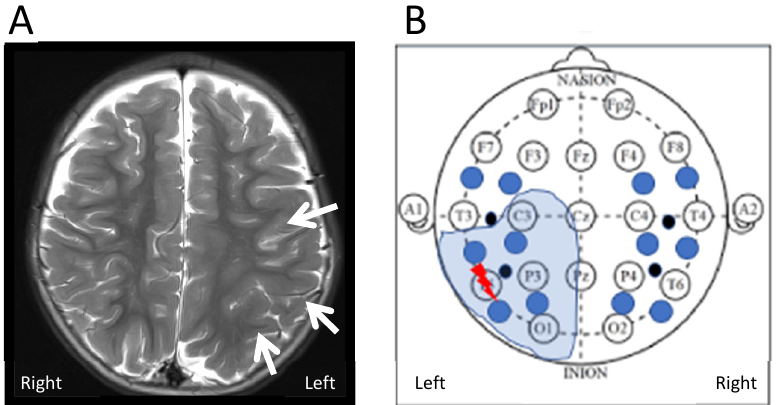
Figure 4. ( A ) Axial T2 weighted images on a 3 Tesla MR scanner show extensive but subtle malfor- mation of cortical development in the left posterior temporo-parietal lobe (arrows). The malfor- mation extends into the occipital lobe (not shown here). ( B ) Schematic correlation of region of FCD identified on MRI with EEG and bNIRS recording setup. The thunder shows the region of origin of the epileptic seizures (epileptic focus) within the extensive FCD (electrode T5). The closest bNIRS channel is L4.